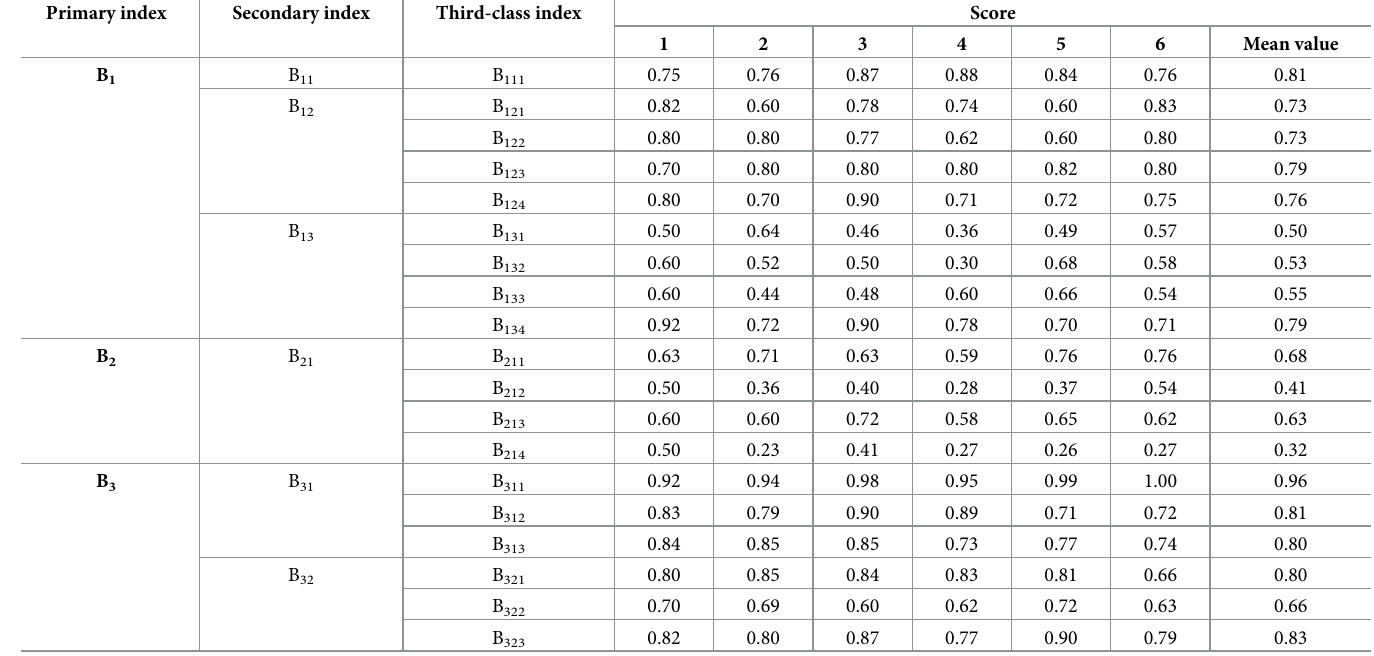
Table 14. Initial index scoring of the brownfield renovation